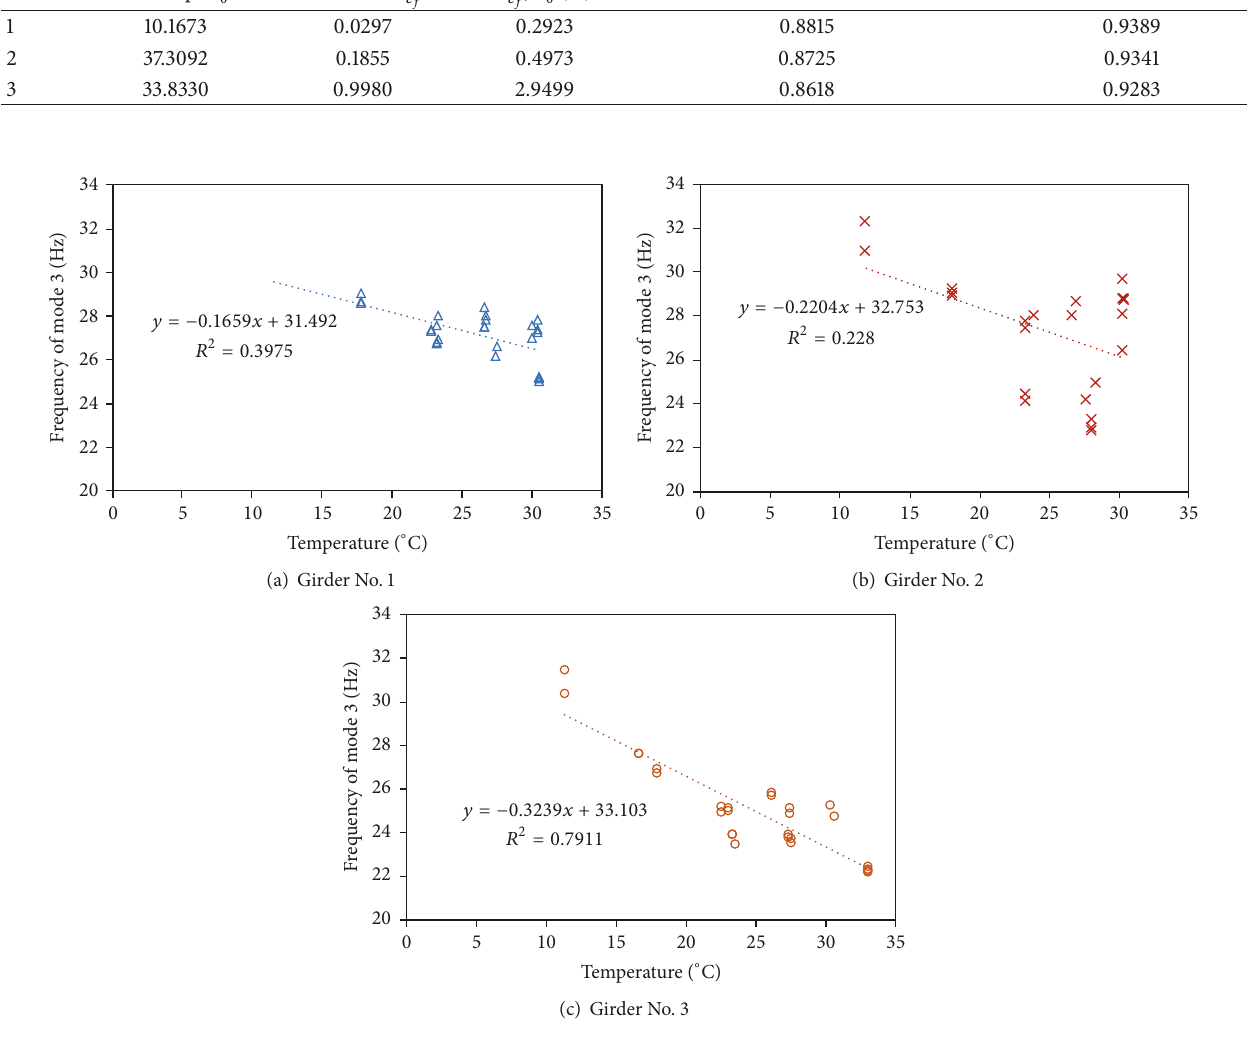
Figure 9: ((a)–(c)) Relation of frequencies of mode 3 to